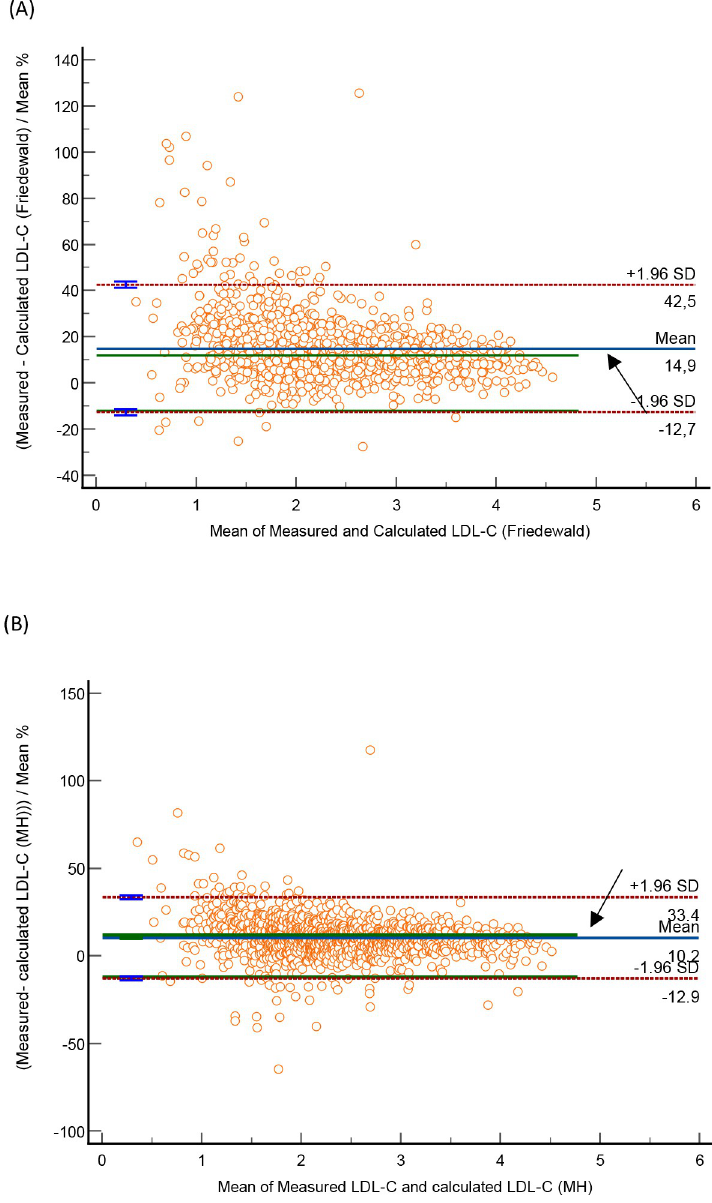
Fig 2. Bland Altman Plots comparing measured LDL-C to calculated LDL-C. Measured LDL-C to Friedewald formula (A) and measured LDL-C to Martin Hopkins formula (B). mismanagement of patients. The higher an individual’s SCORE2 and SCORE2-OP, the lower the target LDL-C. The SCORE2/SCORE2-OP for the very-high risk category is � 10%, with an LDL-C treatment target of 1.4 mmol/L. The very-high risk category includes people with docu- mented atherosclerotic cardiovascular disease (acute coronary syndrome, stable angina, coro- nary revascularization, stroke and transient ischemic attack), diabetes mellitus with target organ damage, type 1 diabetes mellitus for more than 20 years’ duration, severe chronic kidney disease or familial hyperlipidemia with atherosclerotic cardiovascular disease [26].